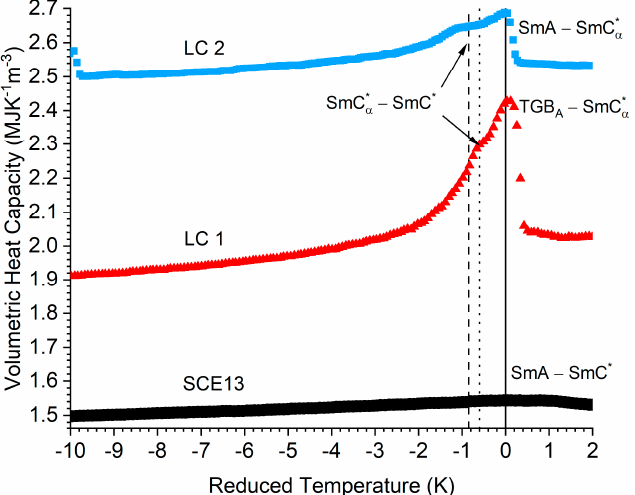
Figure 2. Volumetric heat capacity ( C E ( 0, T 1 ) ) (MJ K − 1 m − 3 ) measured from 2 K above to 10 K below the transition into the ferroelectric phase for each material. The critical temperature was defined as the peak in the heat capacity for each material. For SCE13 (black circles, the peak occurs across the SmA –SmC* transition. For LC 1 (red triangles), the peak occurs across the TGB A –SmC α * transition, and for LC 2 (blue squares), the peak is across the SmA–SmC α * transition. In LC 1 and LC 2, the SmC α * –SmC* transition is marked using dotted and dashed lines (LC 1 and LC 2, respectively).